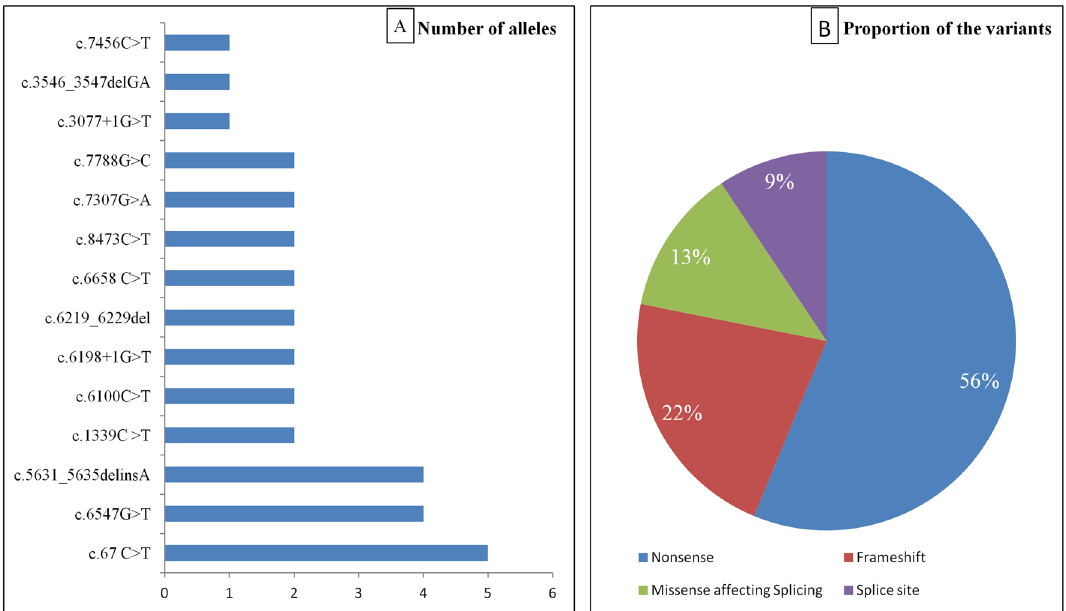
Figure 5. Frequency and effect of various mutations. ( A ) Number of alleles among 16 unrelated cases (32 alleles). ( B ) Proportion of variants according to the effect on the